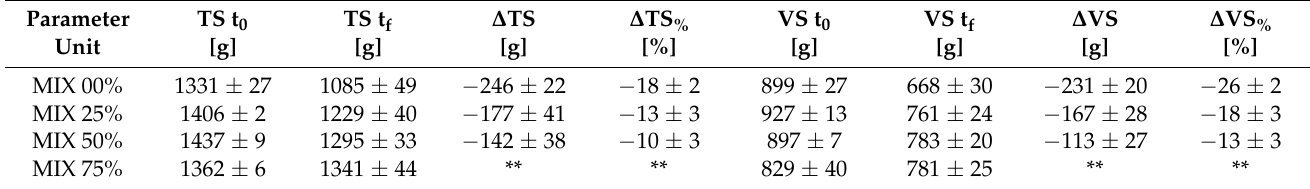
Table 4. Mass balance of total solids (TS) and volatile solids (VS) of the four mixes before and after the composting process.